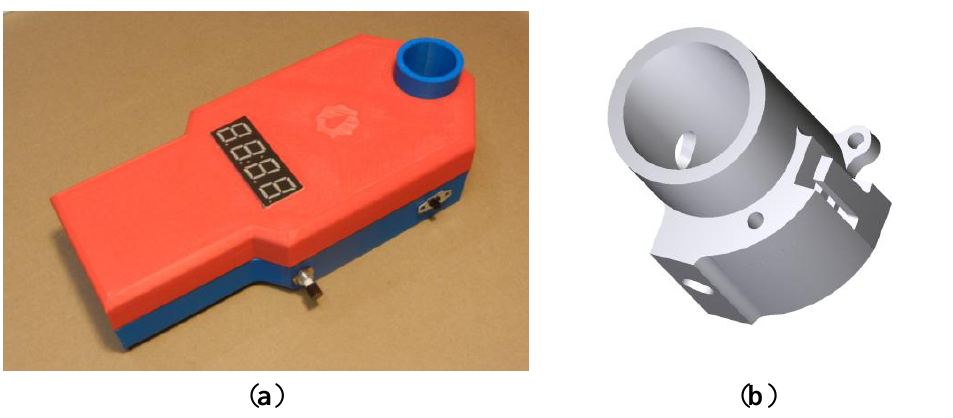
Figure 2. Open-Source Turbidimeter: ( a ) external view, ( b ) image of cuvette holder.